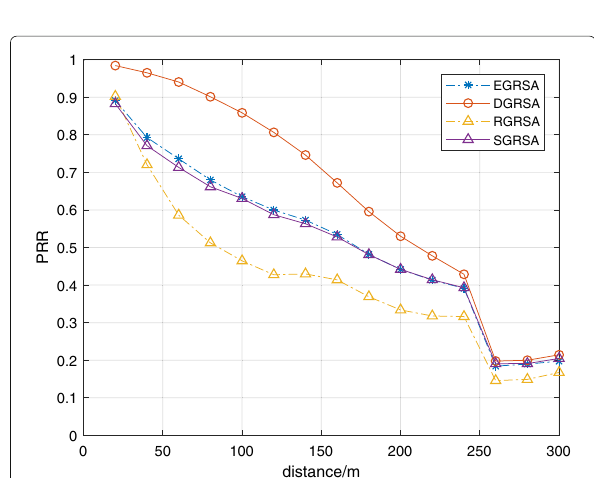
Fig. 22 The PRR of DGRSA when the number of VUEs is 1200 in the jam scene. The packet reception ratio (PRR) curve changes with distance when jam areas are areas 1, 3, 6, 12, and 13 and the number of vehicle user equipments (VUEs) is 1200. Four geo-based algorithms, namely random geo-based resource selection algorithm (RGRSA), sensing geo-basedresourceselection algorithm (SGRSA), the proposed enhanced geo-based resource selection algorithm (EGRSA), and the proposed dynamic geo-based resource selection algorithm (DGRSA), arecomparedinthisfigure. The line with red circles represents the proposedDGRSA. Theline with blue stars represents the proposed EGRSA. The line with purple triangles represents the SGRSA. The line with yellow triangles represents